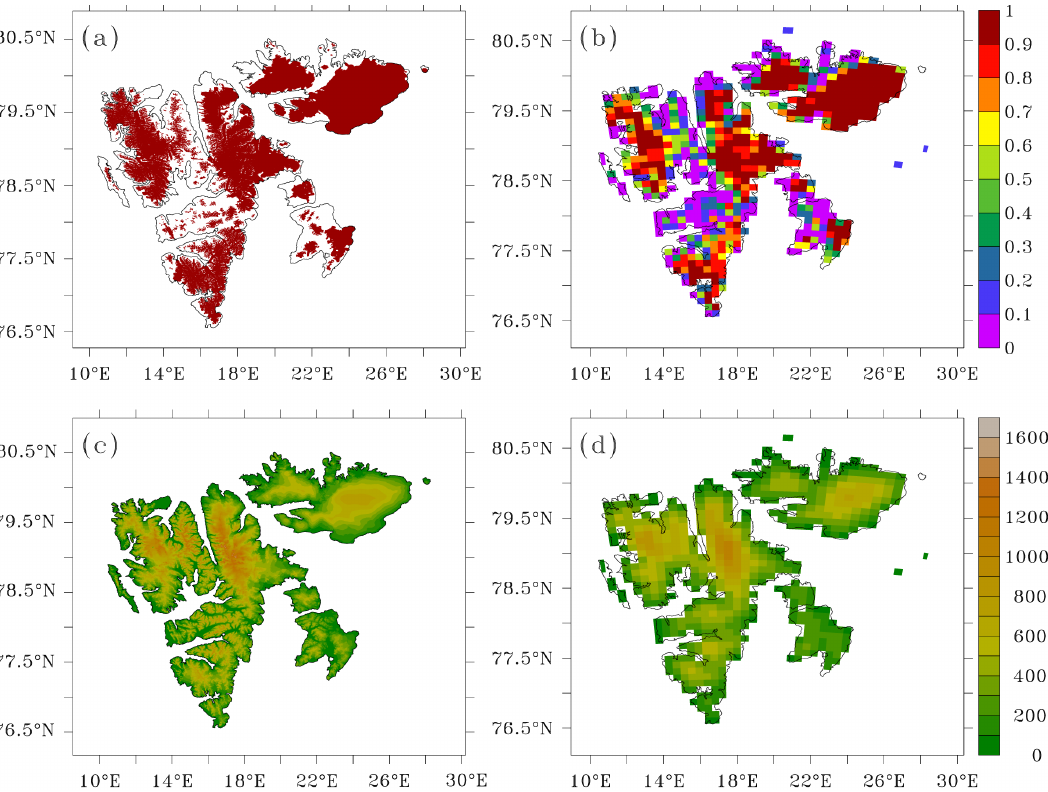
Figure 1. (a) Permanent ice mask from Nuth et al. (2013) interpolated on a 250m grid. (b) Permanent 10km fractional ice mask as used in MAR. (c) Svalbard topography (ma . s . l . ) from the Norsk Polarinstitutt interpolated on a 250m grid. (d) 10km topography as used in MAR (ma . s . l . ). Table 1. Stations used for validation. Period over which data are available, coordinates and elevation of the stations (m), elevation of the corresponding model pixel used in the validation (m) and distance between the station and the pixel (km). Station Period observation Coordinates Elev Pixel elev (m) Dist station-pixel (km) Temperature Precipitation (m) MAR ERA ASR MAR ERA